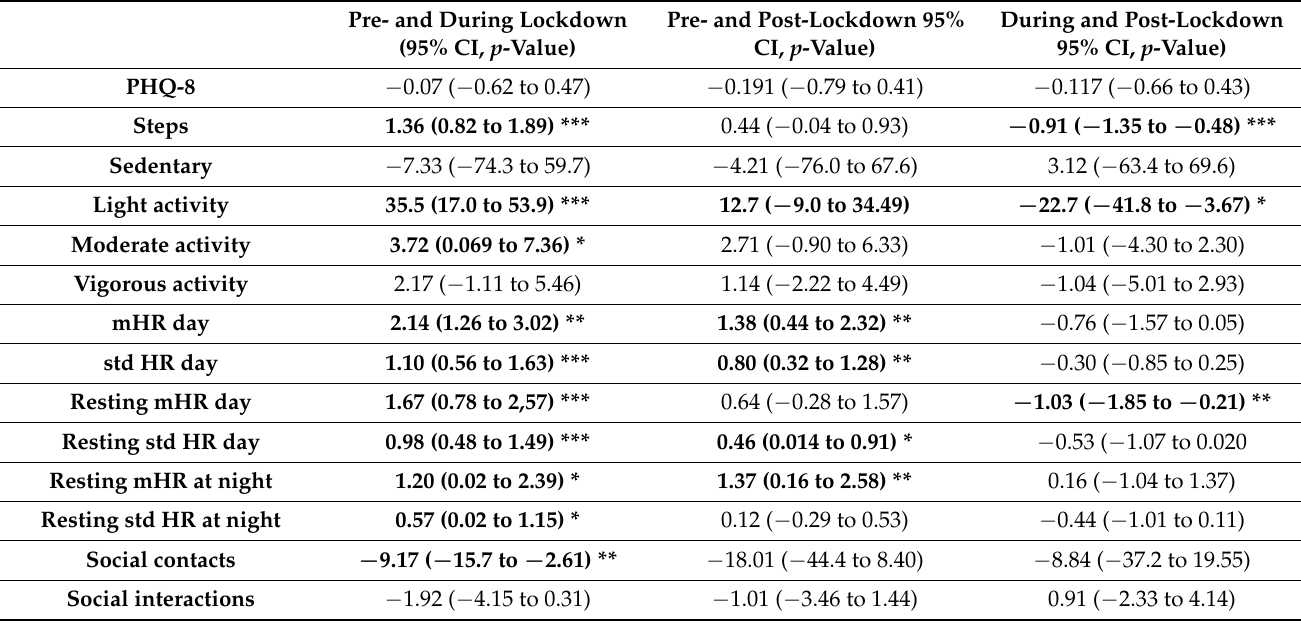
Table 4. Estimated mean differences in each outcome between periods in MS (Linear mixed- effects